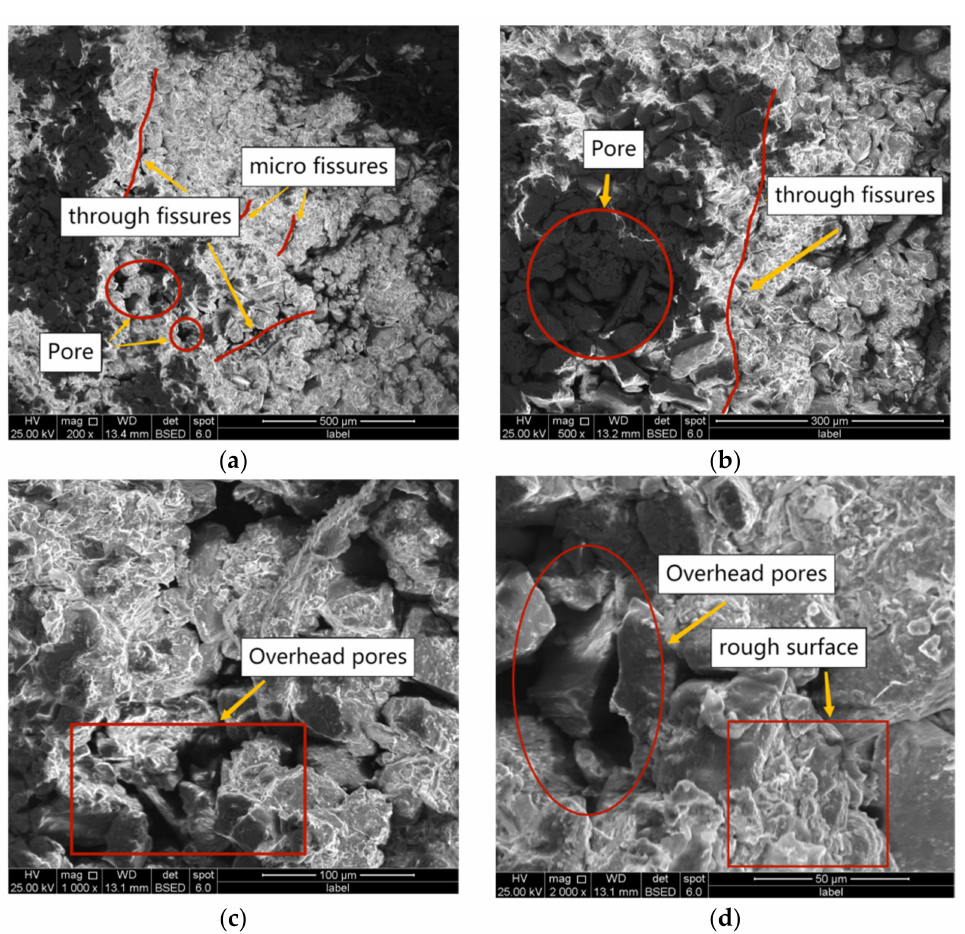
Figure 14. Microscopic image of the original soil sample. ( a ) 200 times; ( b ) 500 times; ( c ) 1000 times; ( d ) 2000